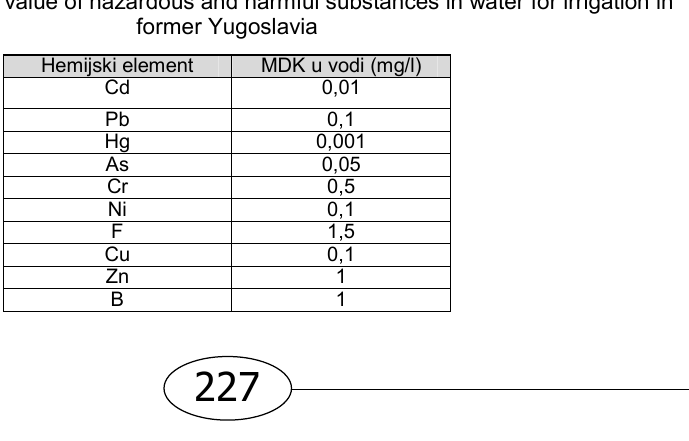
MDK opasnih i štetnih materija u vodi za navodnjavanje u bivsoj